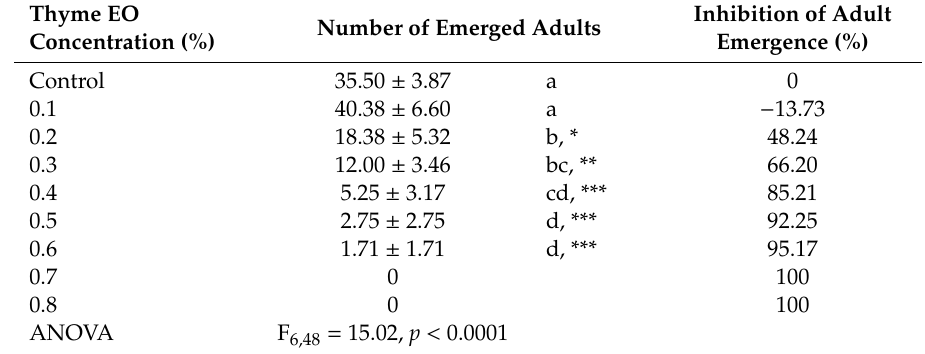
Table 3. Number of emerged Acanthoscelides obtectus adults in F1 generation (means and standard errors for 8 replicates) whose parents were exposed to di ff erent concentrations of thyme essential oil (EO).